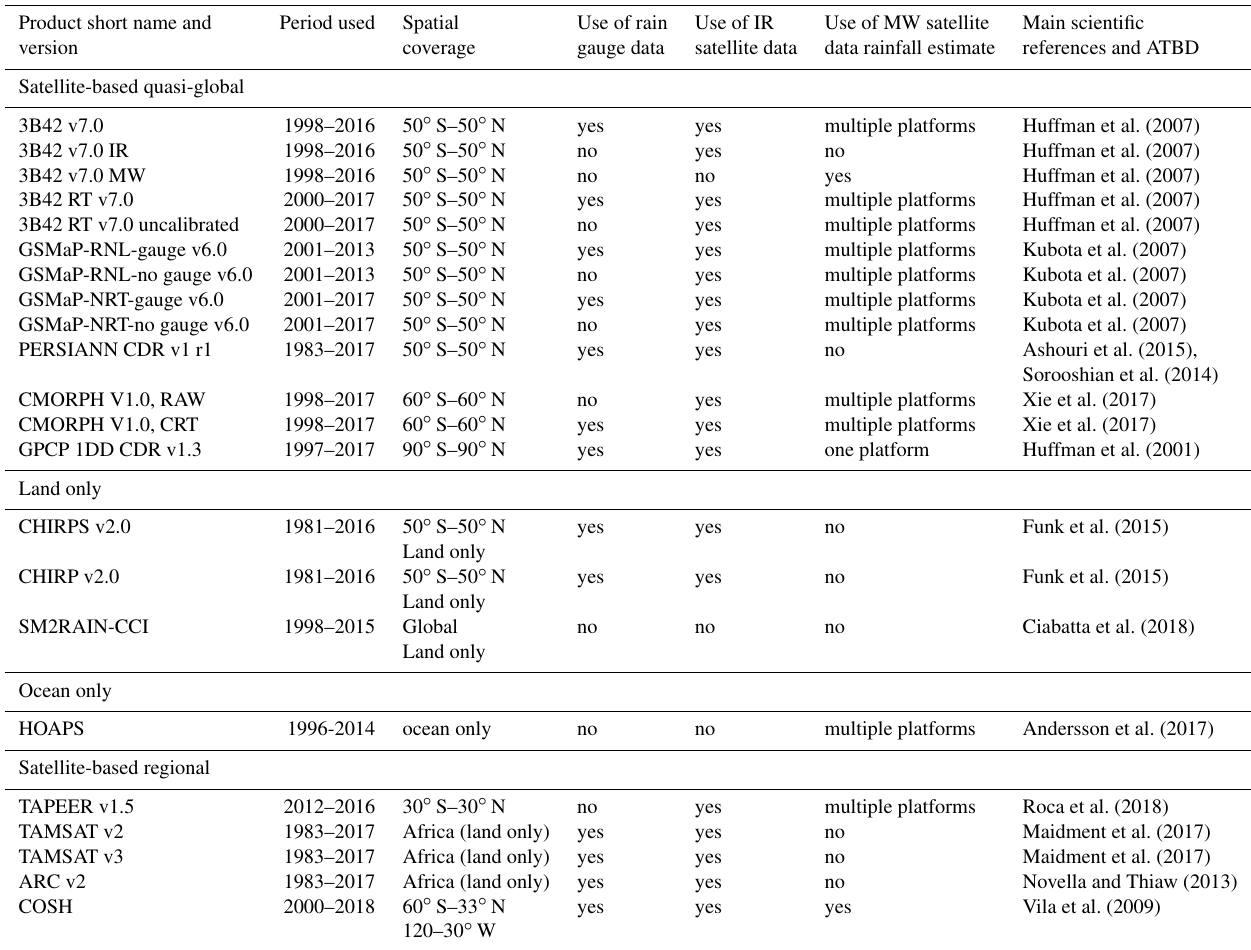
Table 2. The satellite-based datasets. Product short name